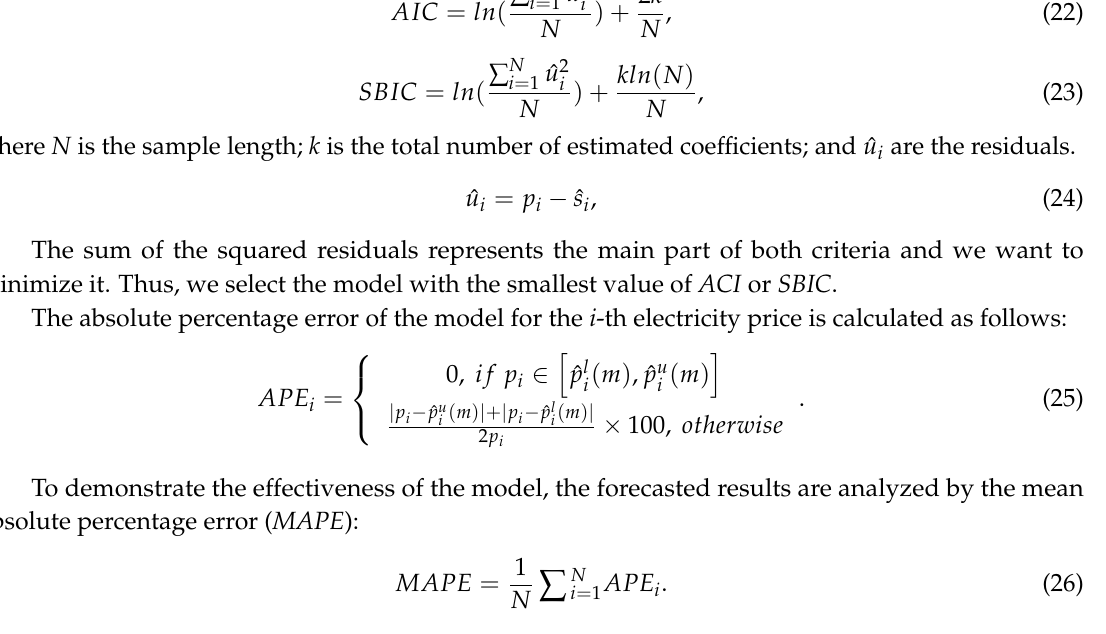
Figure 4. Autocorrelation function for: ( a ) three fuzzy states; ( b ) four fuzzy states; ( c ) five fuzzy states; ( d ) six fuzzy states; ( e ) seven fuzzy states.